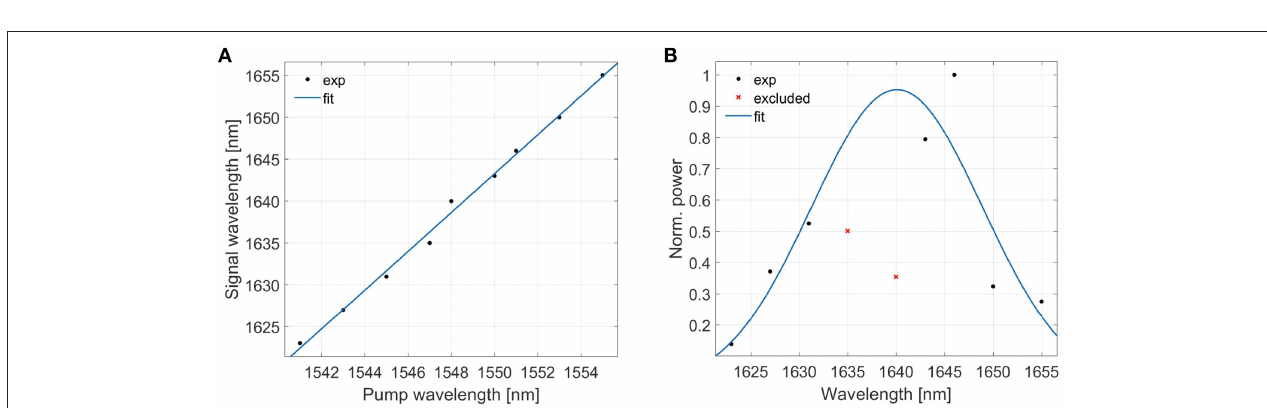
FIGURE 11 | (A) Signal wavelength as a function of the pump wavelength for stimulated inter-modal FWM with 1221TE phase-matching combination in a 4 µ m wide waveguide. The pump is CW. The seed idler wavelength is fixed at 1,467nm. The black dots are the experimental points. The line refers to a linear fit of the data. (B) Normalized signal generated power as a function of the signal wavelength. In black are the experimental points used for the gaussian fit of the data. In red the experimental points excluded from the